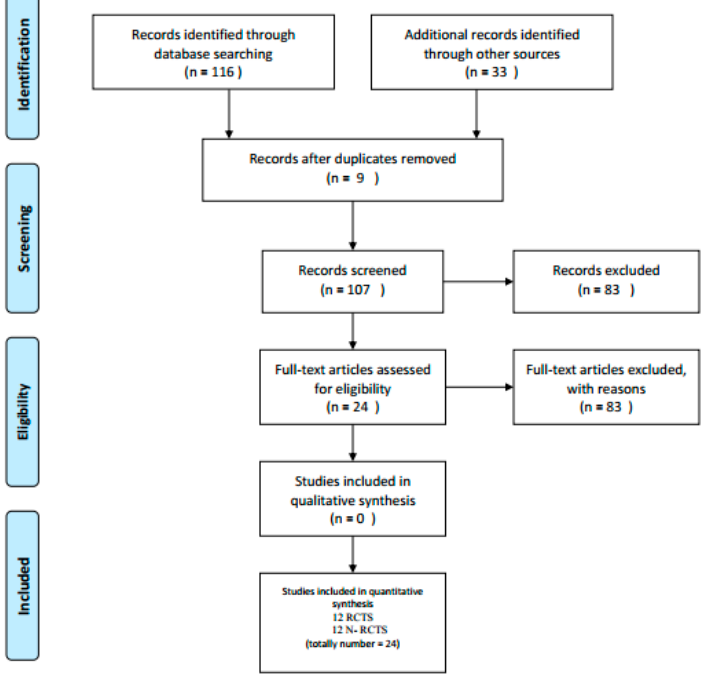
Figure 1. Flow diagram for the selection of papers to be included in the review.